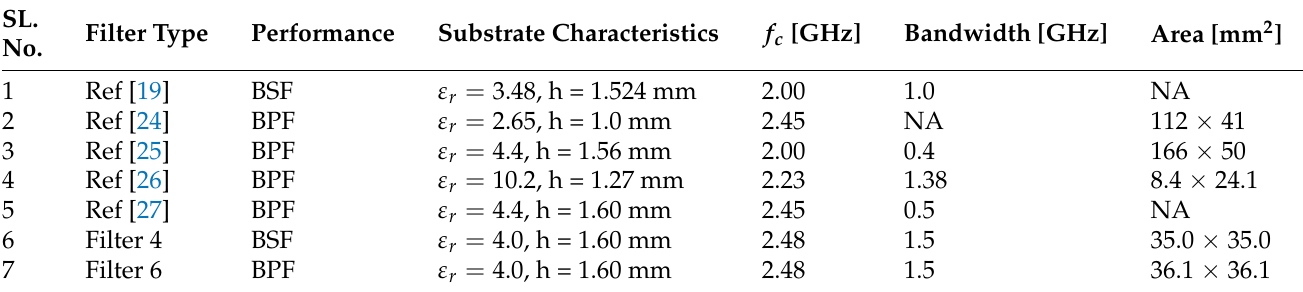
Table 4. Comparison of referred band stop and band pass